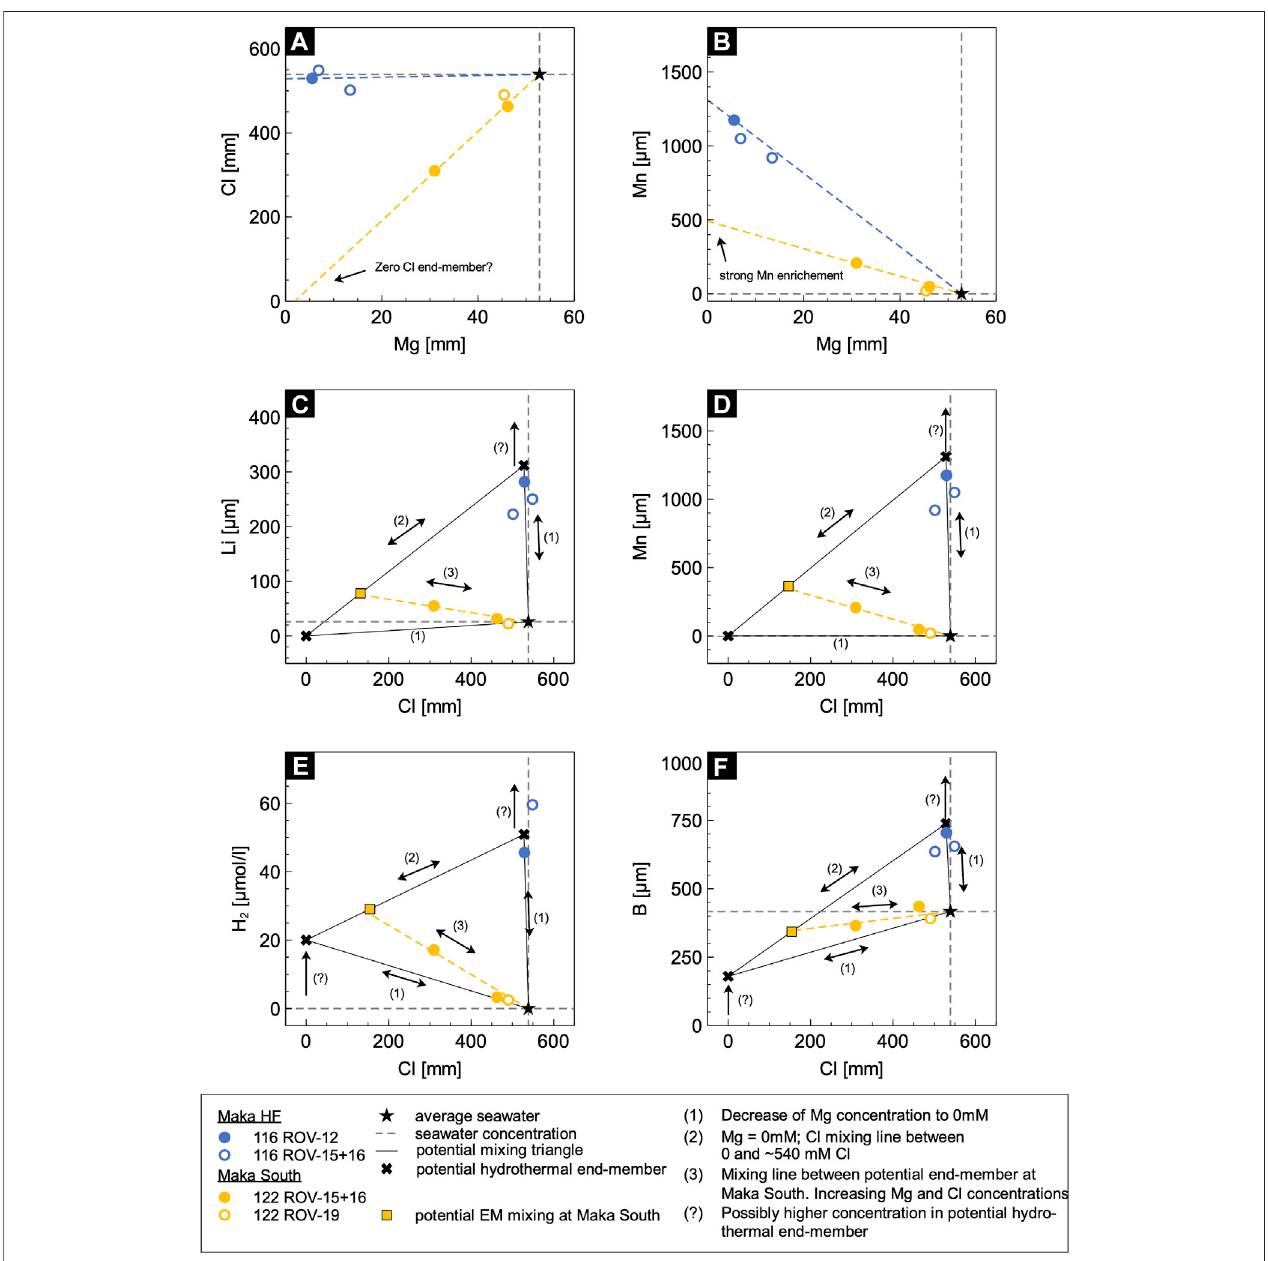
FIGURE 11 | Bivariate diagrams of (A) Cl – Mg, (B) Mn – Mg, (C) Li – Cl, (D) Mn – Cl, (E) H 2 – Cl, (F) B – Cl. Linear least squares regression to 0 Mg indicate two different hydrothermal end-members. (C – F) Mixing triangle for three component mixing between (i) black smoker-type fl uids similar to Maka HF, (ii) boiling-induced low- Cl vapour and (iii)